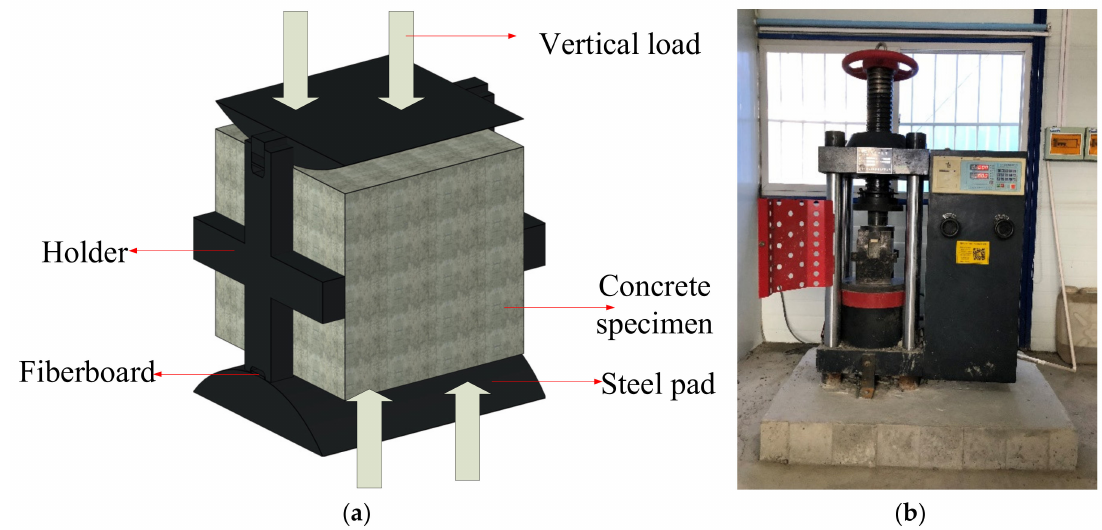
Figure 4. Setup for split tensile strength test: ( a ) Schematic diagram of test; ( b ) Photo of test.